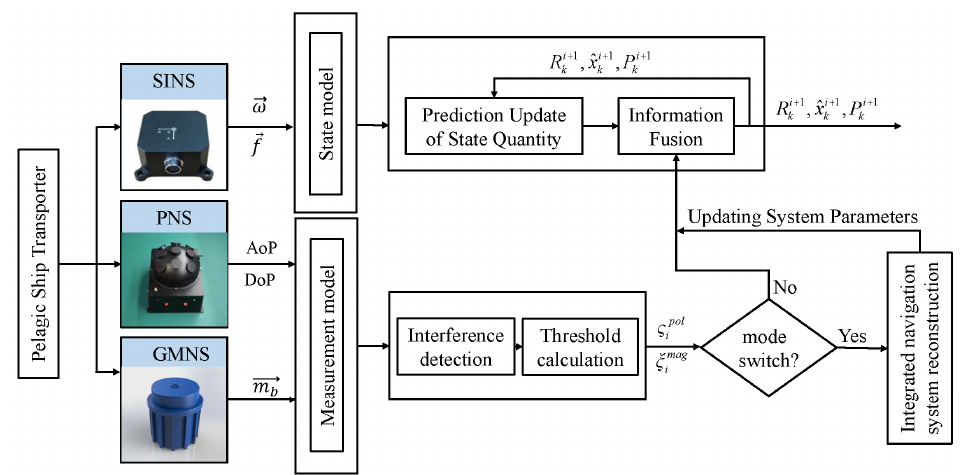
Figure 1. The SINS/PNS/GMNS integrated navigation filter architecture diagram.